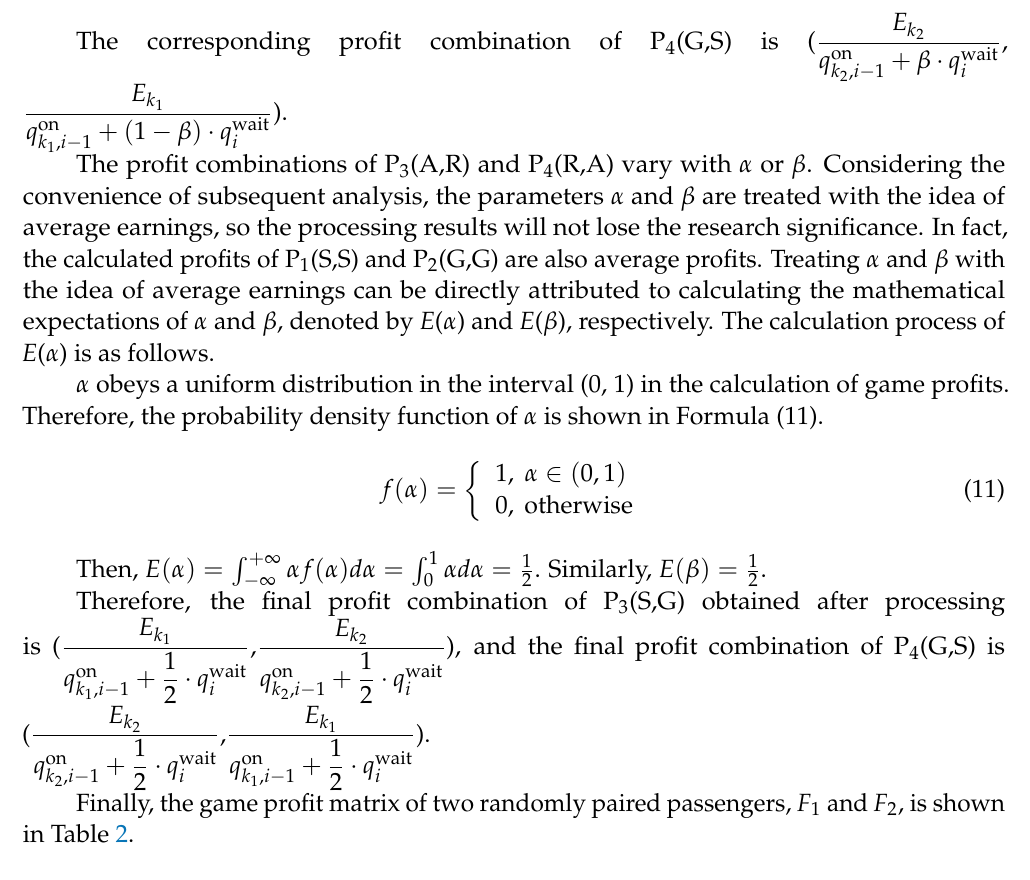
Table 2. Profit matrix of